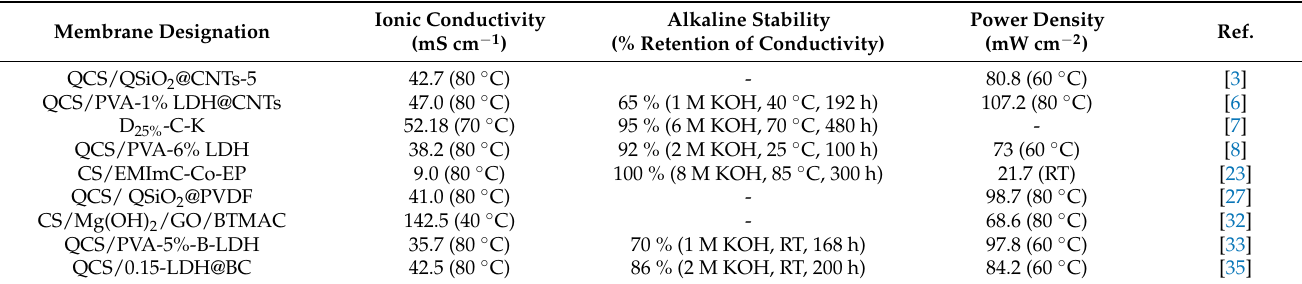
Table 1. Properties of various AEMs suitable for